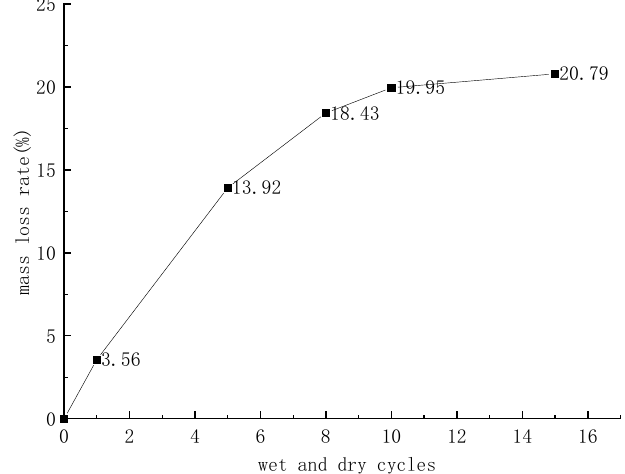
Figure 4. Mass loss rate of 4G8S10 under different wet and dry cycles.